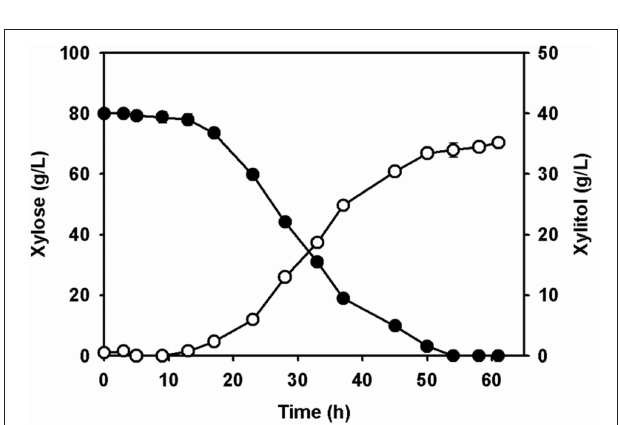
FIGURE 5 | Batch fermentation of the xylose extract by the adapted Candida tropicalis strain CBS94 in a 1.1-jar fermenter. Profiles of xylitol (open circle) and xylose (filled circle) in fermenter were analyzed by